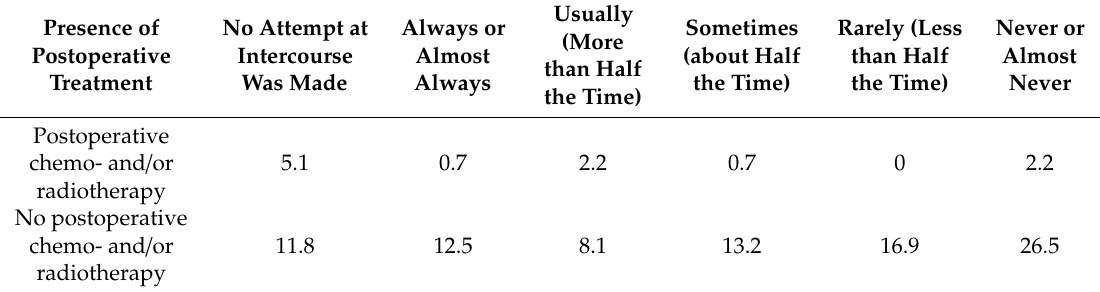
frequency of experiencing discomfort or pain during intercourse. Results are presented as percentages